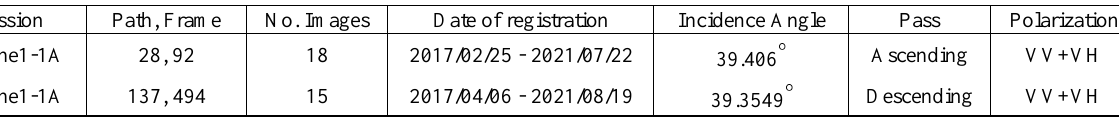
Table 1. Sentinel-1A data characteristic on descending and ascending